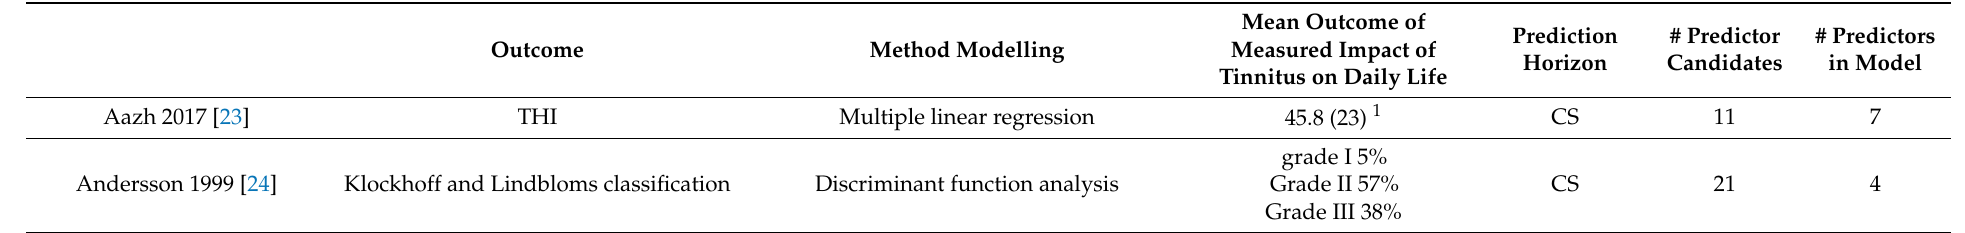
Mean Outcome of Prediction # Predictor # Predictors Measured Impact of Horizon Candidates in Model Tinnitus on Daily Life